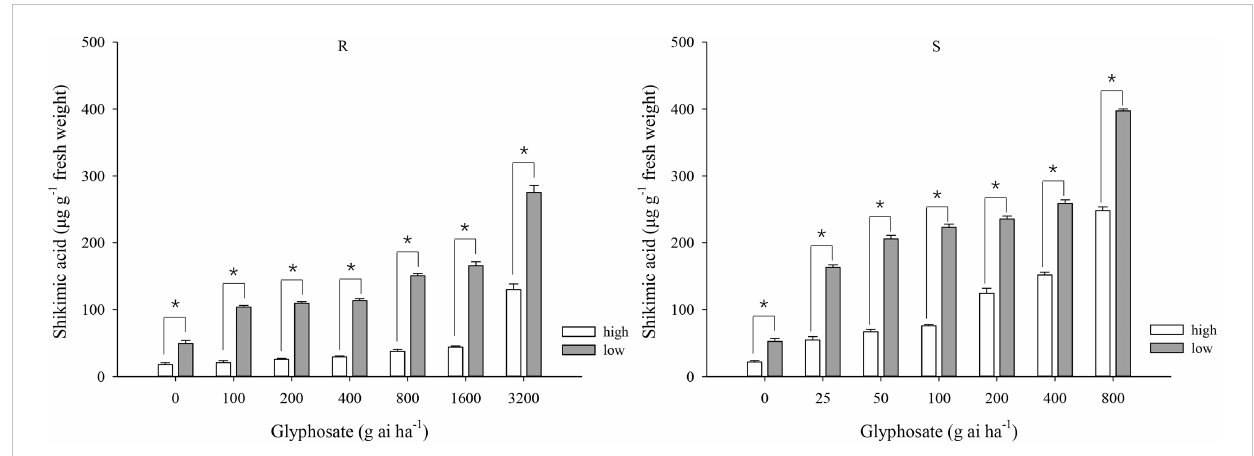
FIGURE 2 Shikimic acid accumulation in leaf tissue of glyphosate-resistant (R) and -susceptible (S) Eleusine indica biotypes at 4 days after glyphosate treatment under high temperature (30°C/25°C day/night) and low temperature (20°C/15°C day/night) regimes. Each data point is the mean ± standard error of three biological replications. An asterisk indicates a signi fi cant difference in shikimic acid content within the same glyphosate treatment between temperature regimes (Student ’ s t -test, a =